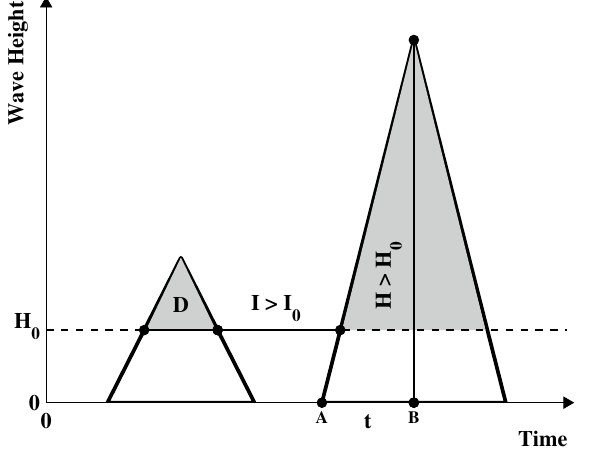
Figure 6. Triangular sea storm model. Graphical illustration of the Triangular Sea Storm model. Shown are: the wave height threshold H 0 , the inter-storm period I larger than the threshold I 0 , the sea storm duration D , a sea storm wave height H larger than H 0 , and the approximate duration t of the climatic event generating the sea storm (the temporal segment AB )—see text. The shaded regions indicate successive triangular sea